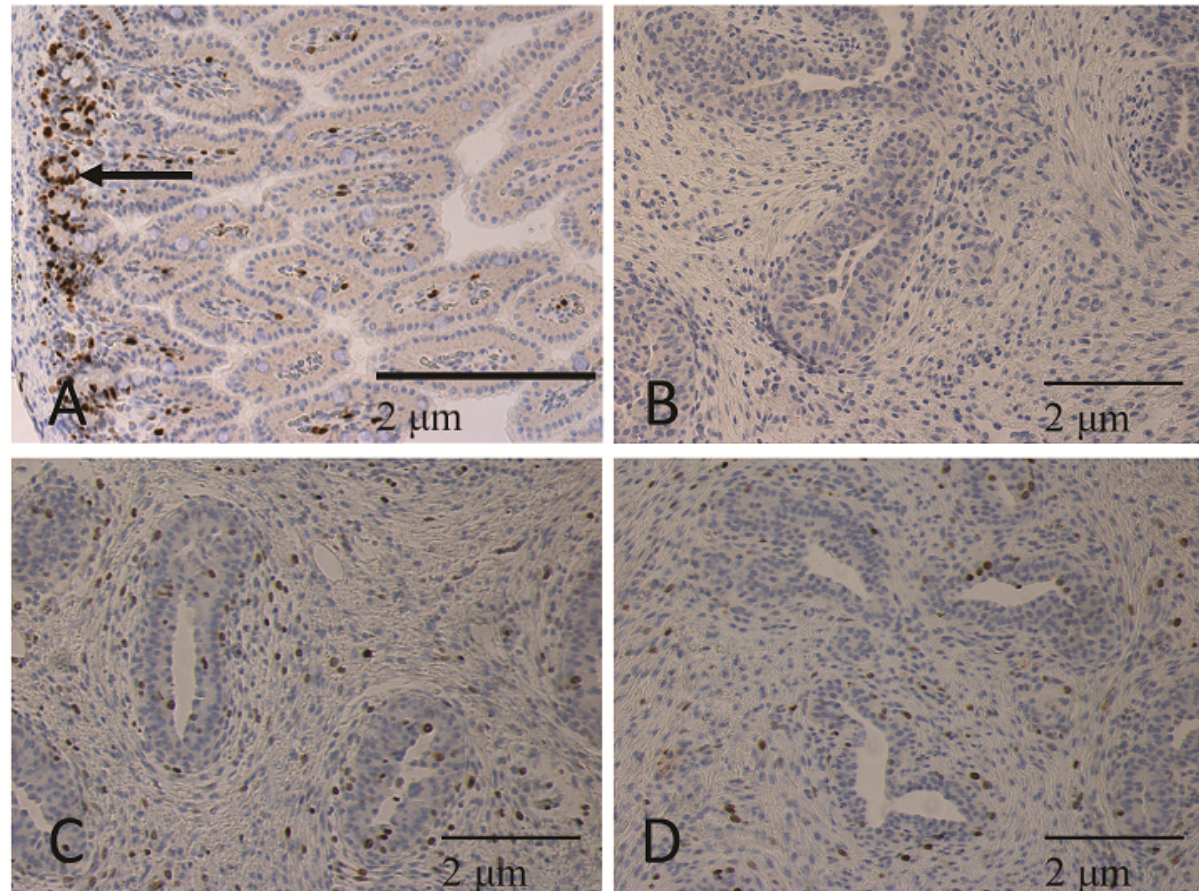
Figure 3. Tissues immunostained for KI67 (brown) and counterstained with hematoxylin. ( A ) Jejunum was collected from gilts and used as a positive control for KI67 labeling of proliferating cell populations in tissues. Arrow indicates crypt region of villi. Immunostaining of KI67 shows that epithelial cells within the crypt region of the villi were immunostained, whereas those lining the villi of the jejunum were mostly lacking positive cells. ( B ) Negative control mammary tissue was incubated with rabbit IgG rather than primary antibody and show a lack of brown nuclei. Mammary tissue from ( C ) COL10 and ( D ) COL20 gilts immunostained with KI67 have positively stained cells in the epithelial and stromal components of the parenchymal compartment. Images were captured at 200×. Table 4. DNA yield, mean fraction (f) and fractional synthetic rate (FSR) of DNA and protein and the ratio of these factors in mammary parenchymal tissue over the first seven days postnatal in gilts